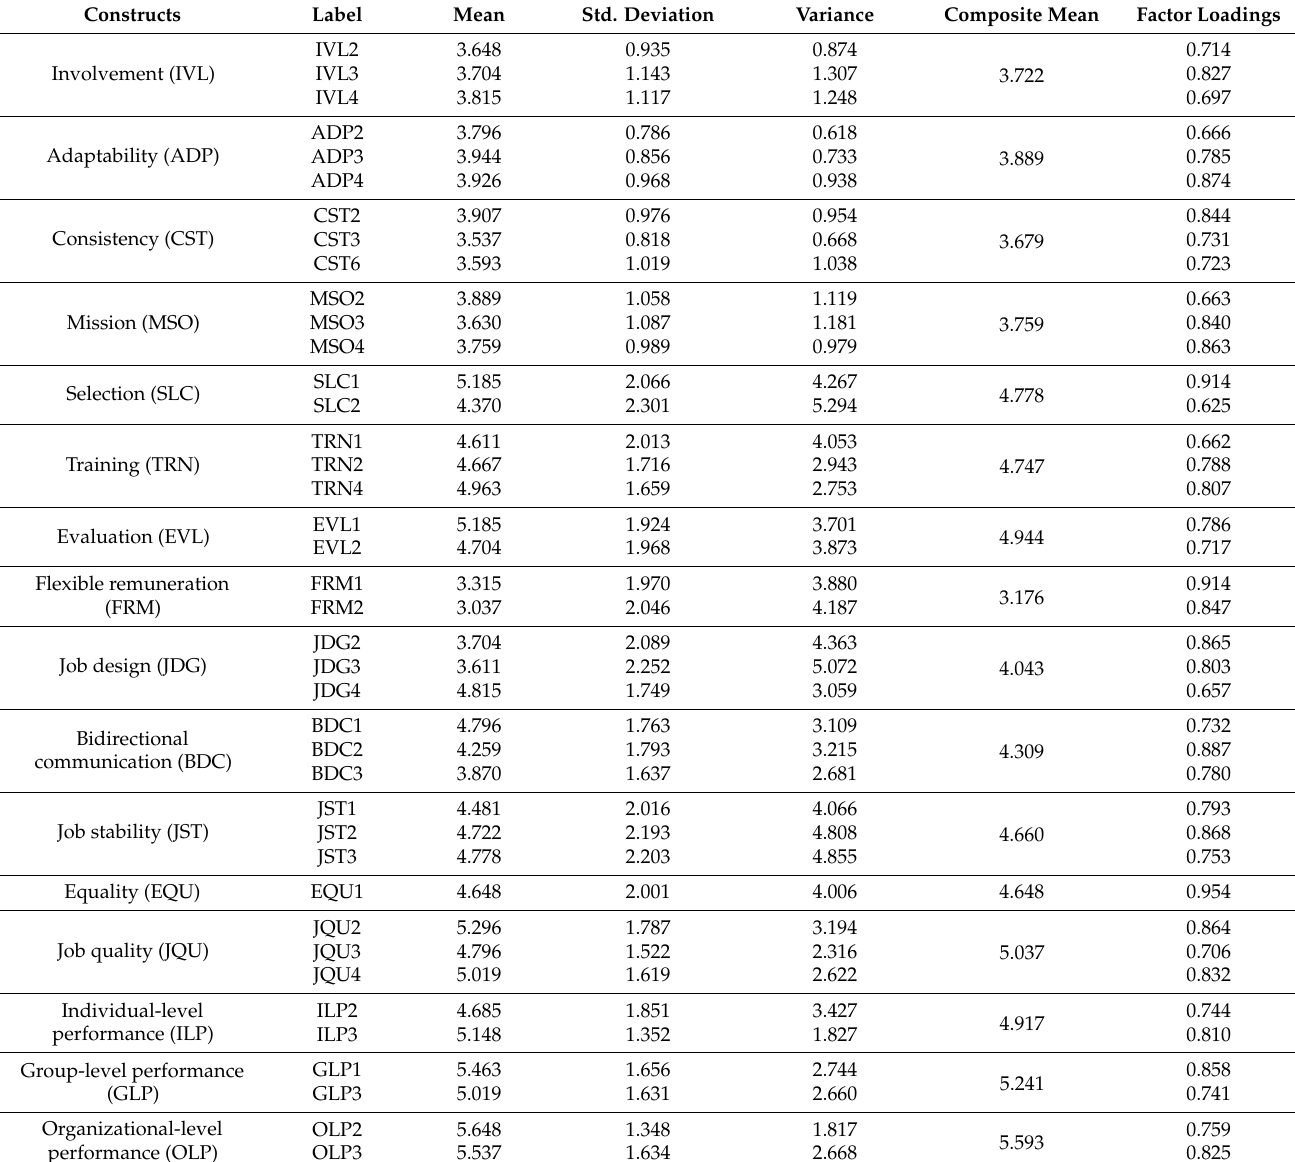
Table 2. Descriptive statistics and exploratory factor